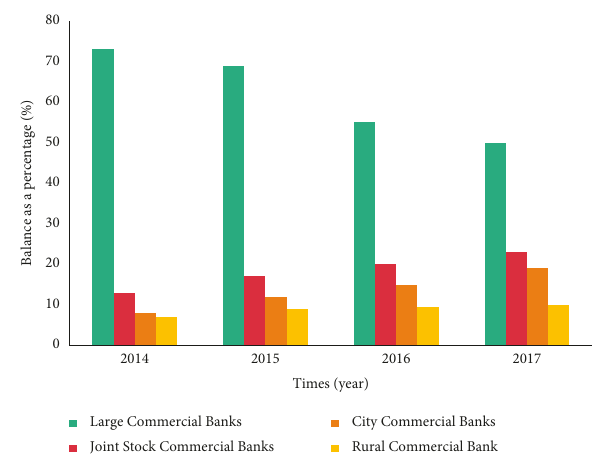
Figure 5: Trend chart of outstanding nonperforming loans of all banks.